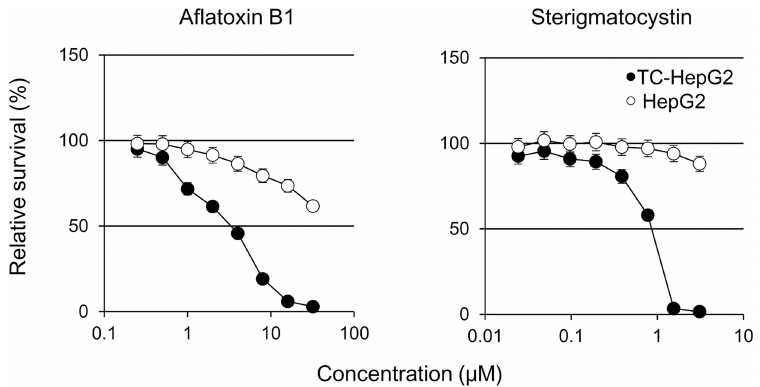
Fig 7. Assessment of compound-associated toxicity in TC-HepG2 cells. Aflatoxin B1 and sterigmatocystin requiresCYP-mediated activationto form cytotoxic and DNA-reactive intermediates. Symbols represent means ± S.D. of triplicate